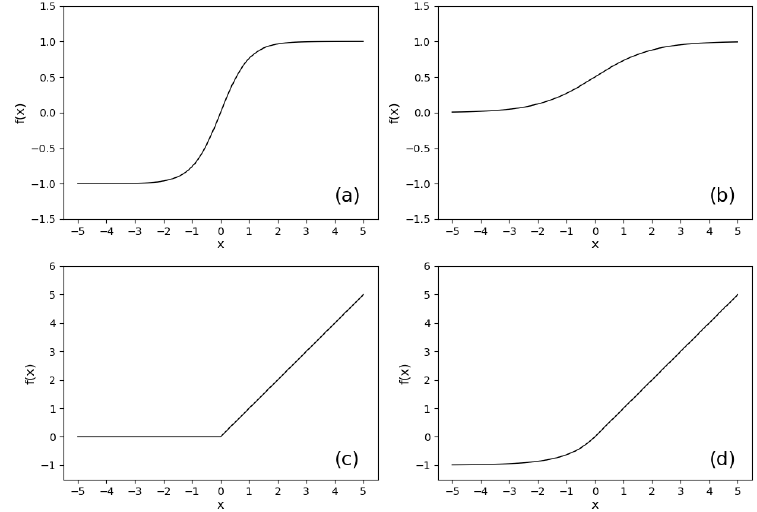
Figure 3. Activation functions: ( a ) Tangent hyperbolic, ( b ) Sigmoid, ( c ) ReLU, and ( d ) Selu